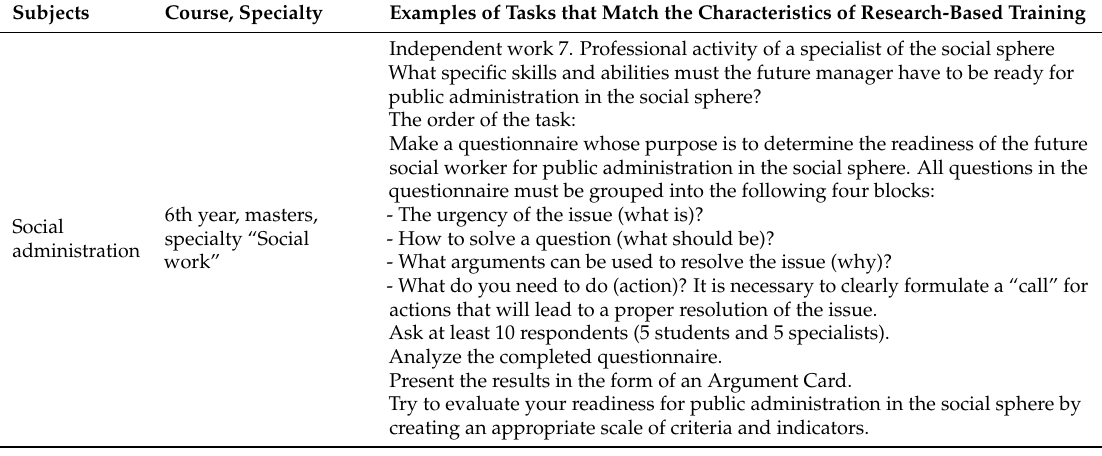
Table 1. Results of the analysis of educational disciplines for the presence of tasks that match the characteristics of research-based